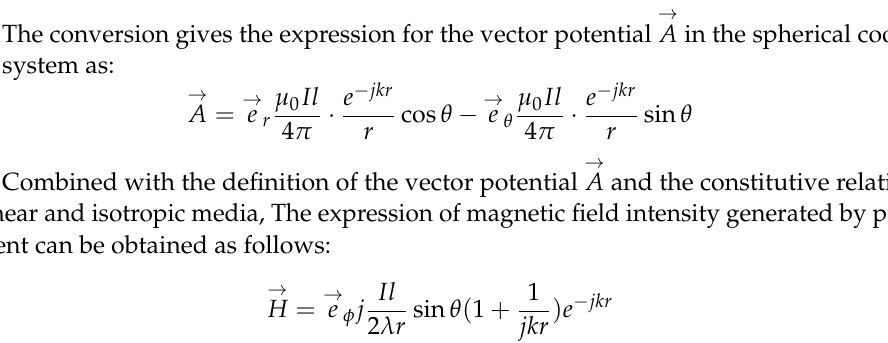
Figure 4. Schematic of pulse current.